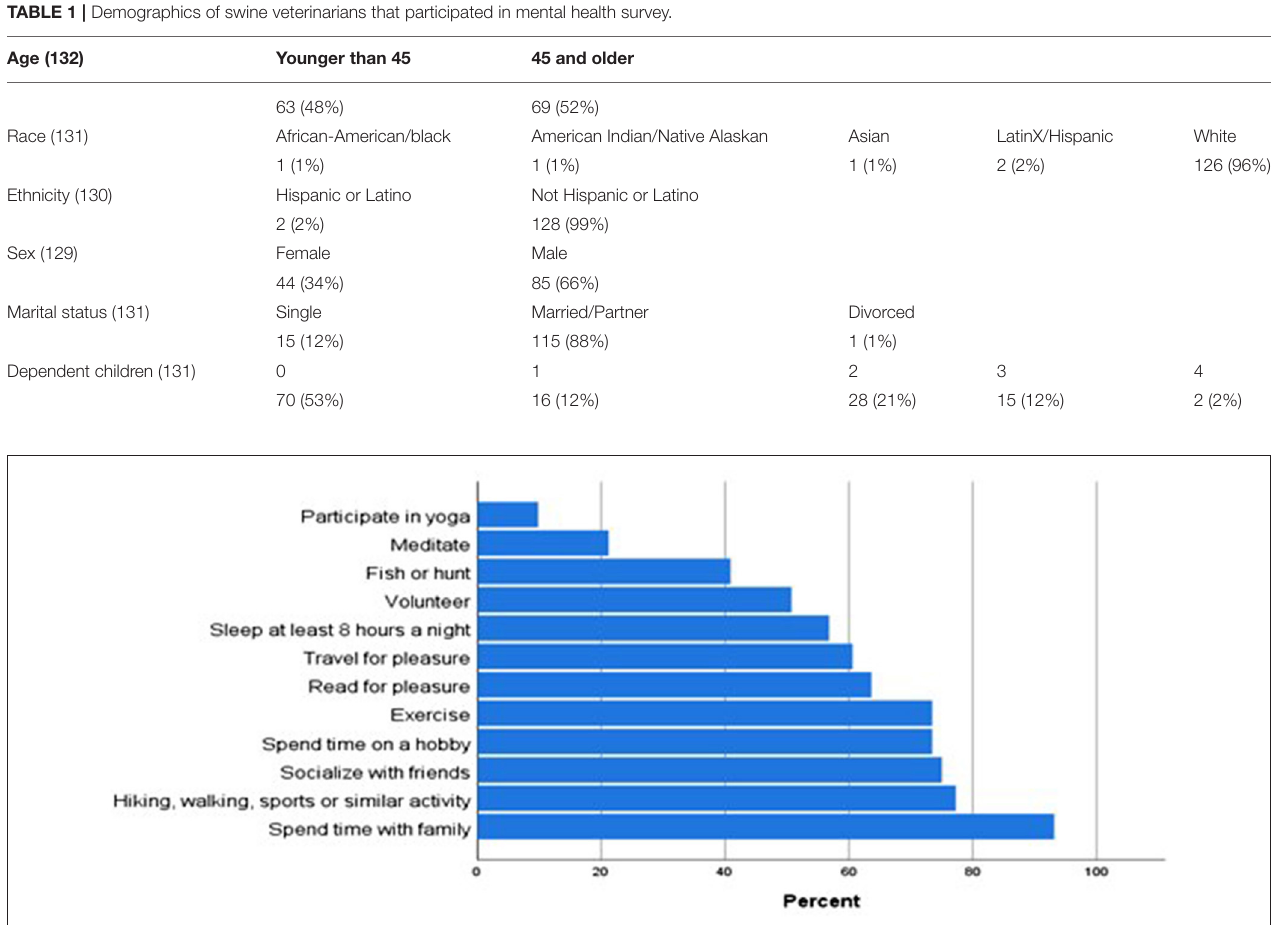
TABLE 1 | Demographics of swine veterinarians that participated in mental health survey.